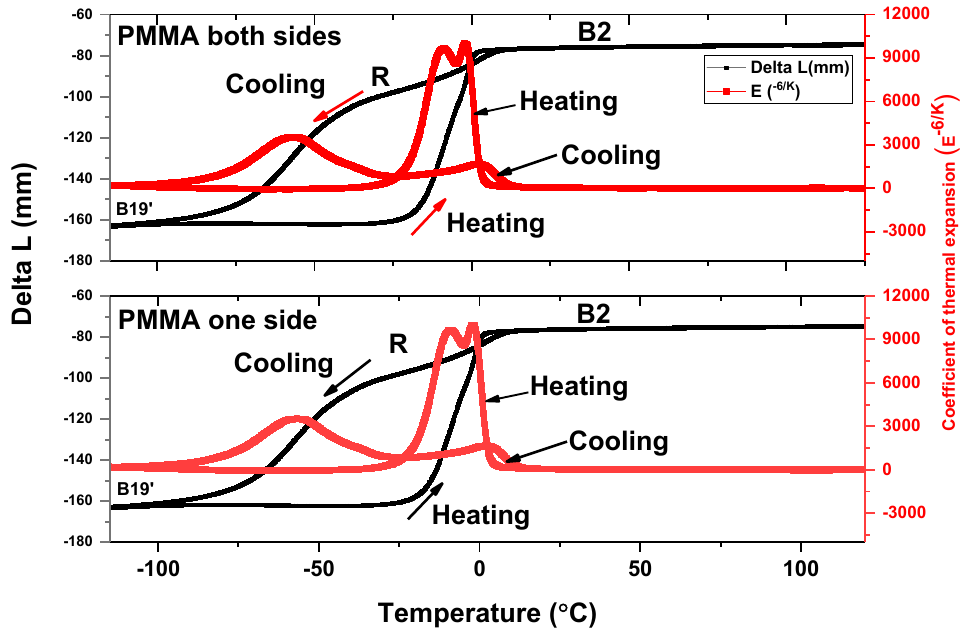
Figure 8. Hysteresis behavior of the PMMA-Ni-Ti composite (one side and both sides) surface as a function of the temperature.